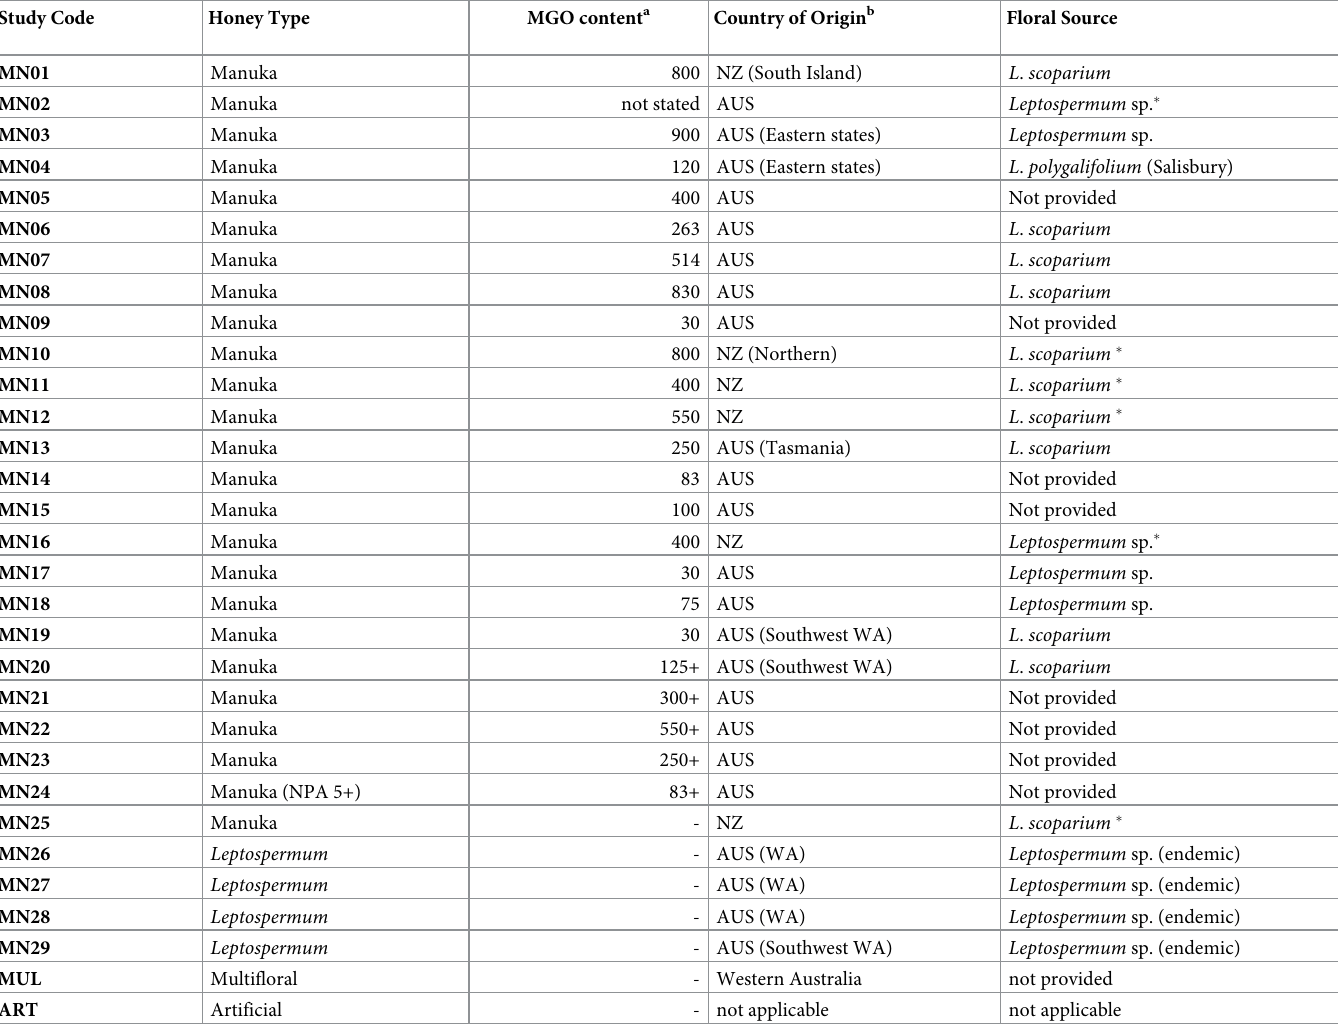
Table 1. Floral source, country of origin and MGO levels as stated on product labels, for manuka/ Leptospermum honeys and comparators. Study